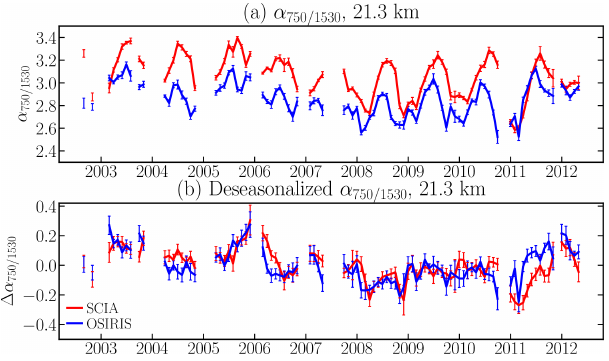
Figure 7. Mean relative (a) and absolute (b) differences (200 × (SCIAMACHY-instrument)/(SCIAMACHY+instrument)) between Ångström exponents from collocated SCIAMACHY and SAGE II ( α 525 / 1020 : blue lines) and SCIAMACHY and OSIRIS ( α 750 / 1530 : red lines) measurements. Shaded areas show standard error of the mean.